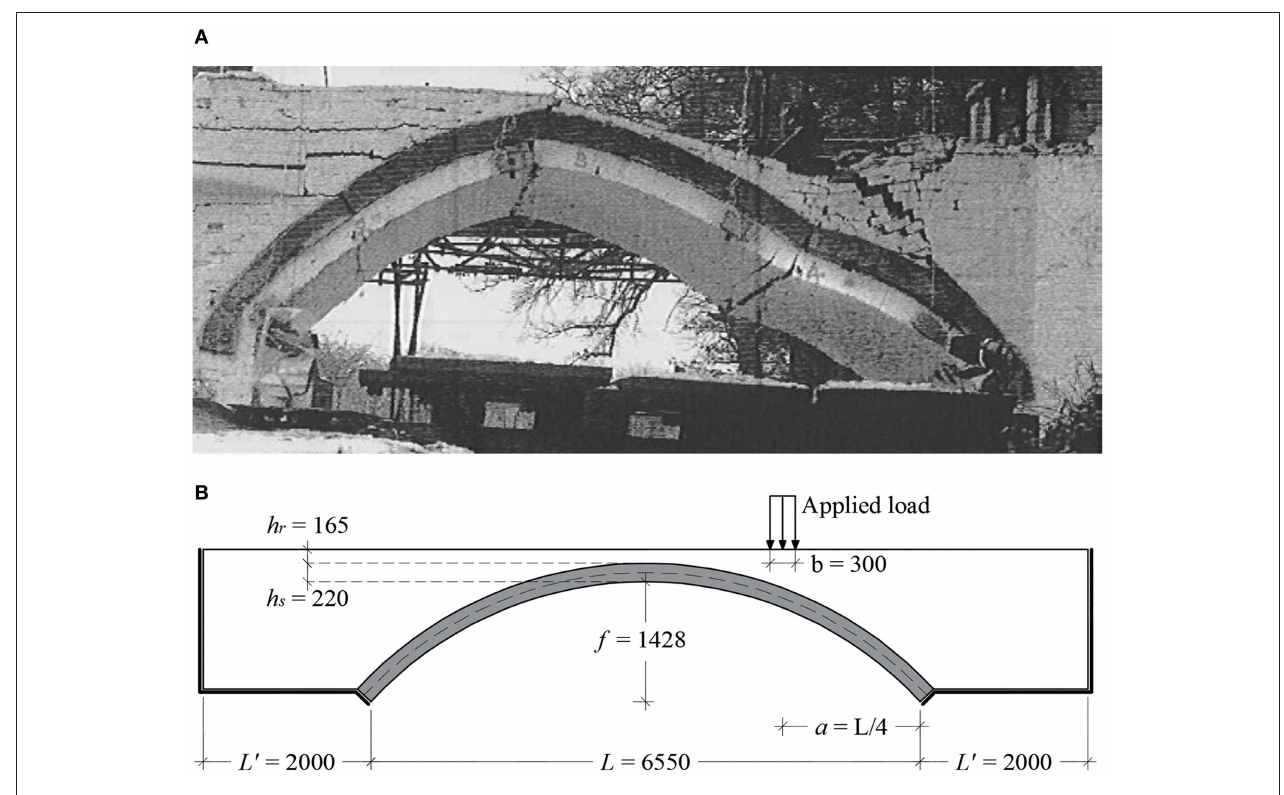
FIGURE 7 | Prestwood bridge (A) collapse; (B) geometrical properties.